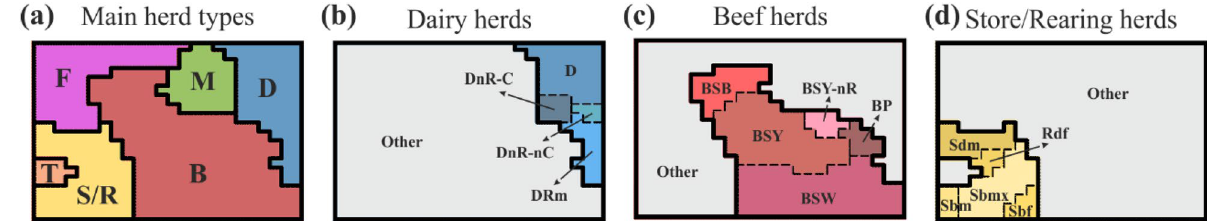
Figure 4. Class boundaries of the 17 identified herd types in the final self-organising map (see Fig. 3). ( a ) Main herd types in Ireland: dairy (D), beef (B), mixed (M), store/rearing (S/R), fattening (F), and trading (T) herds. ( b ) Dairy herd types: dairy (D), dairy no rearing—contract (DnR-C), dairy no rearing—no contract (DnR-nC), dairy rearing male calves (DRm). ( c ) Beef herd types: beef pedigree (BP), beef suckling to weanling (BSW), beef suckling to youngstock (BSY), Beef suckling to youngstock—no rearing (BSY-nR), Beef suckling to beef (BSB). ( d ) store/rearing herd types: store dairy males (Sdm), store beef males (Sbm), store beef females (Sbf), store beef mixed (Sbmx), rearing dairy females